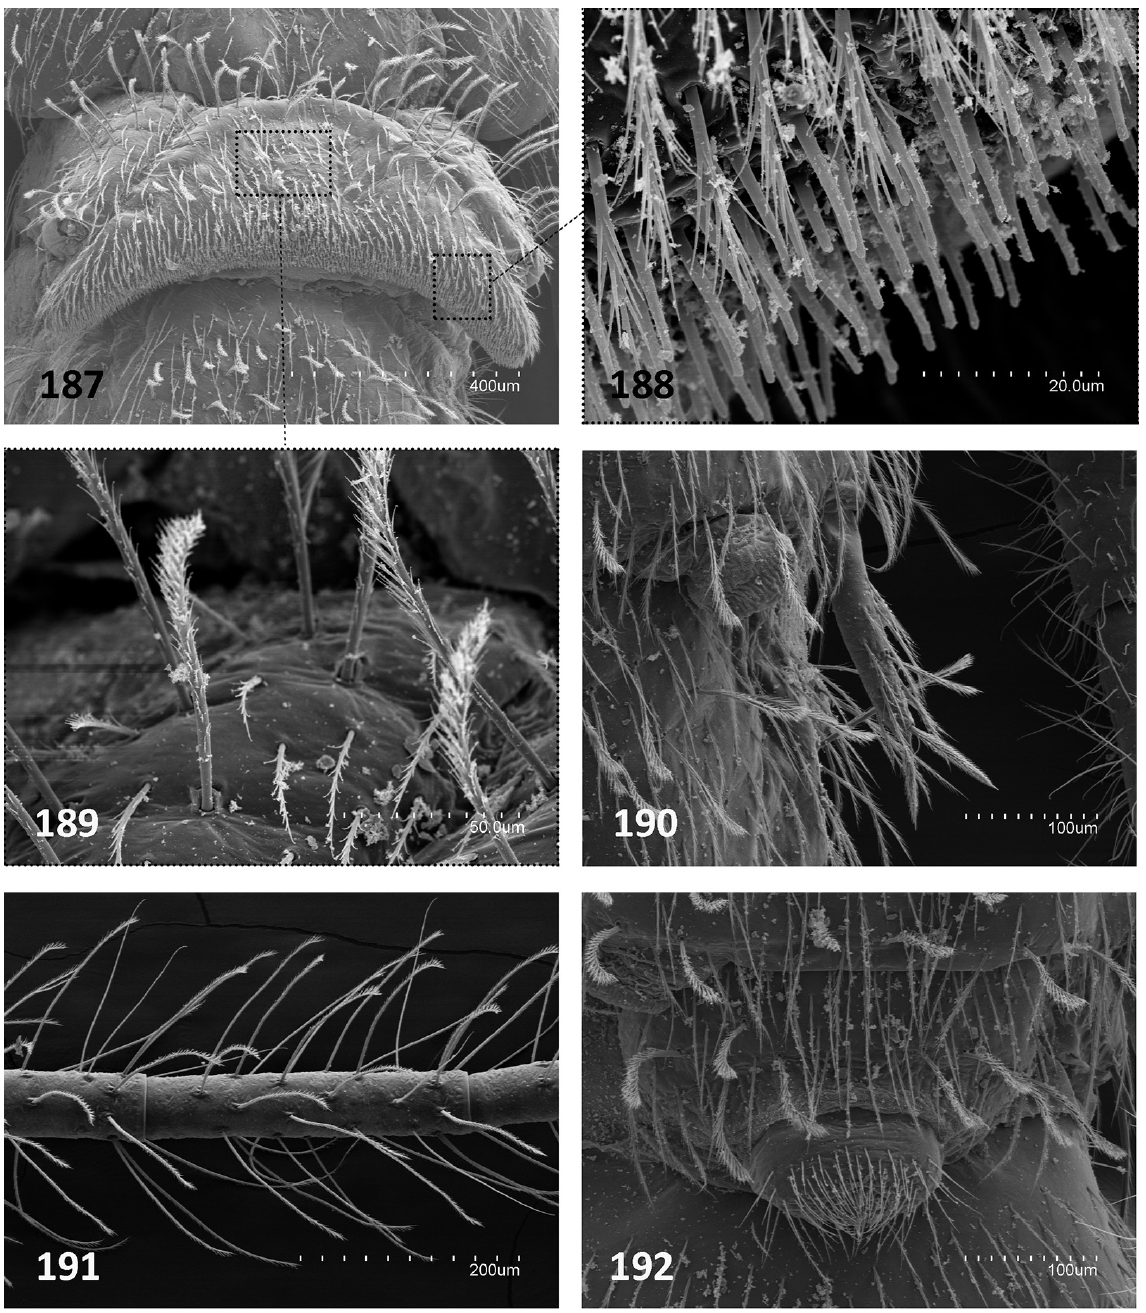
Figs 187–192. Plusiocampa ( Stygiocampa ) remyi Condé, 1947, from Njegoš pećina, Njeguši, Kotor, Montenegro (187–190, 192) and Đatlo pećina, Lebršnik, Gacko, Bosnia and Herzegovina (191) (Coll. AS). 187 . ♂, urosternite I (appendages missing). 188 . ♂, edge of urosternite I, detail. 189 . ♂, macrosetae on urosternite I, detail. 190 . Lateral posterior view of urosternite V. 191 . Second cercal article. 192 . ♂, urosternite